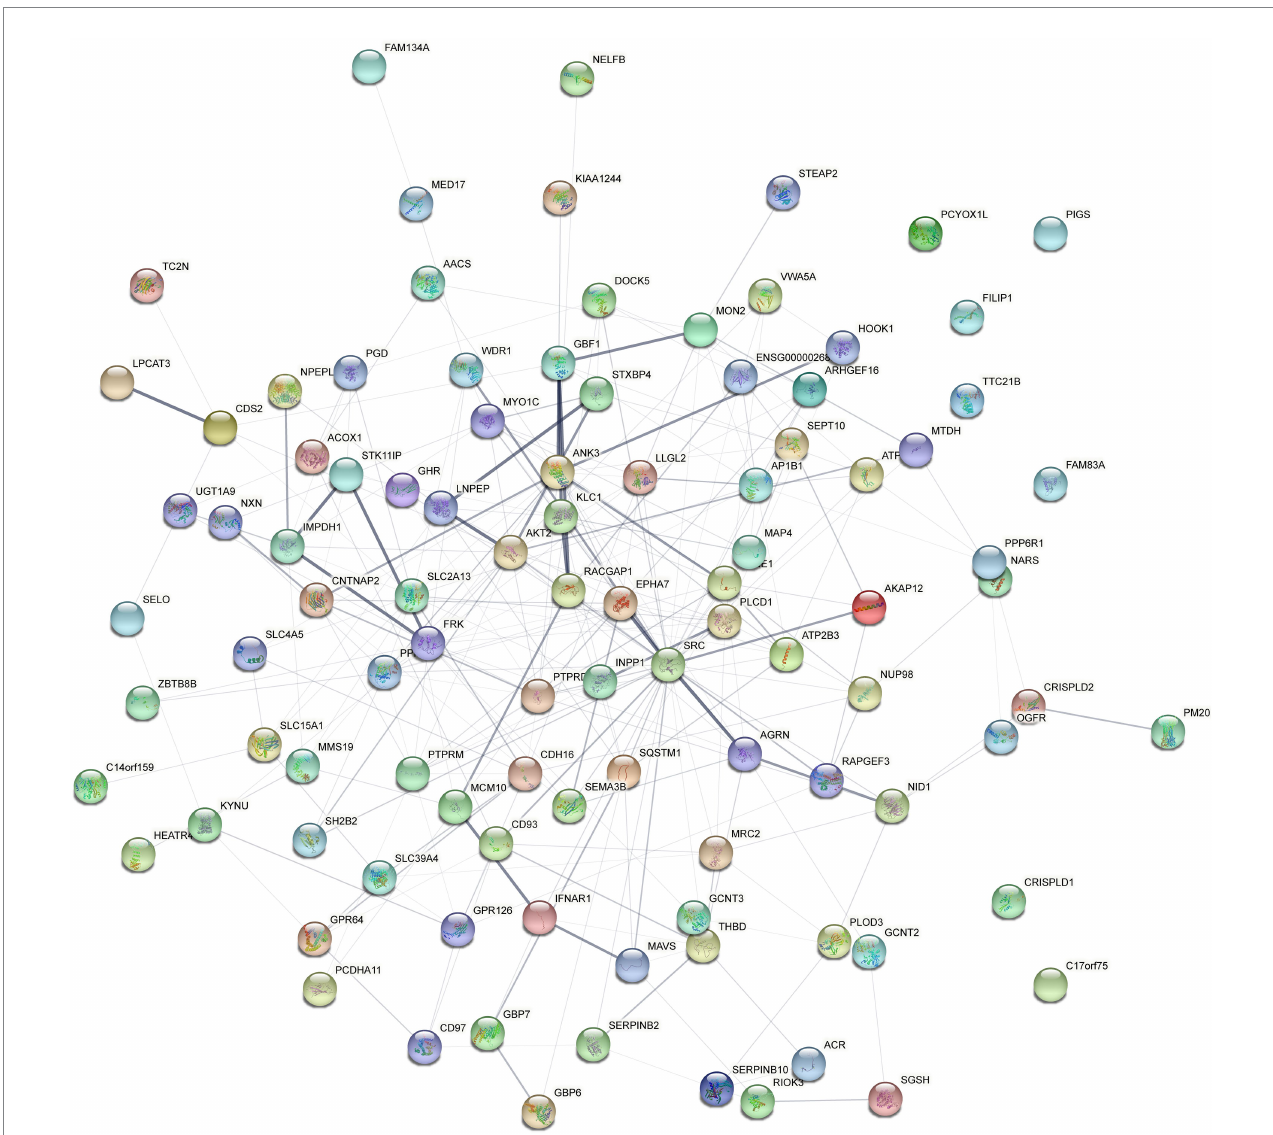
FIGURE 6 Protein–protein interaction (PPI) network analysis of the differential expressed proteins in the urine between VD and other two groups (AD and NC) using STRING. Each node represents a protein, and each edge represents a protein–protein